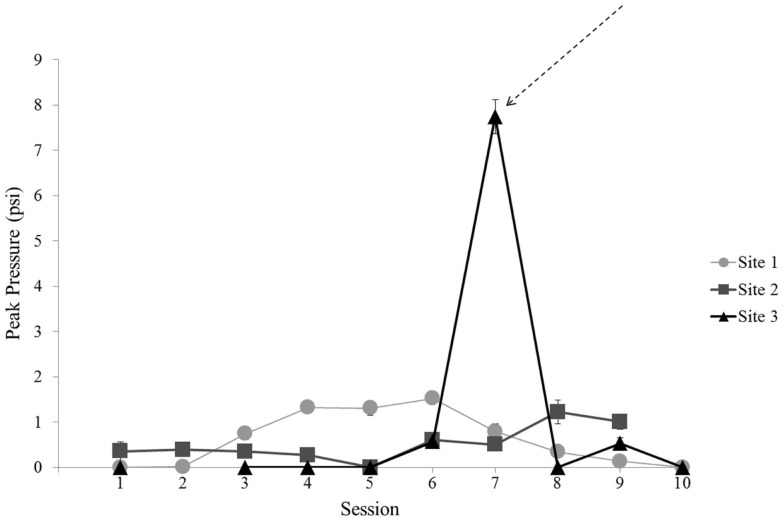
Mean blast magnitude [peak pressure (psi)] recorded for each Session for each site. Error bars are standard error. Data are not included for Session 2 at Site 3 due to the use of alternate recording equipment in that Session. The arrow indicates the unique Session selected for focused analysis of greatest blast magnitude on UCH-L1 concentration.